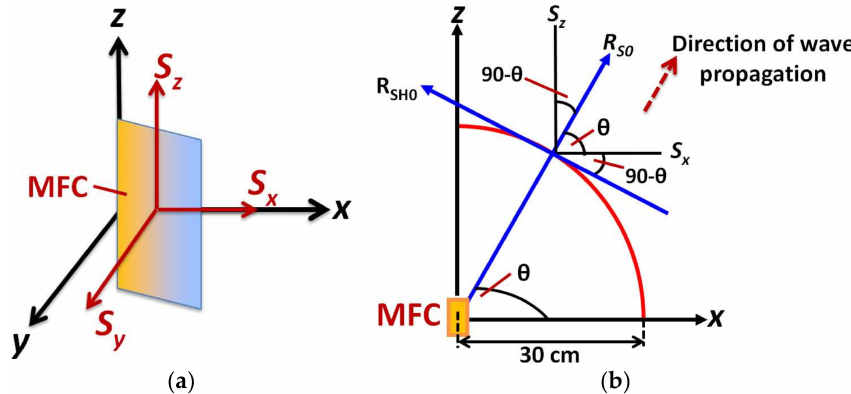
Figure 6. Calculation of resultant signals in FE numerical modelling: Showing signal components of particle velocity ( S x, , S y and S z ) along the axis ( a ) and resultant/received signals in the direction of propagation ( R S0 ) and perpendicular to the direction of propagation ( R SH0 ) ( b ).